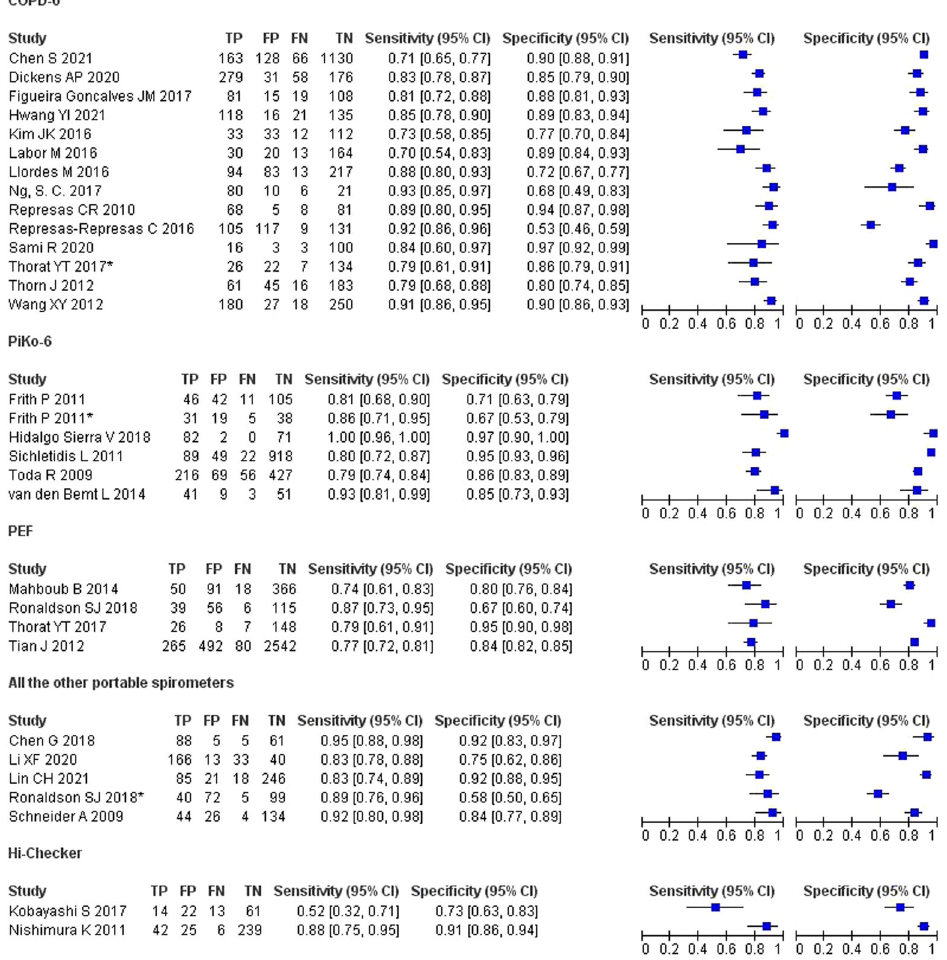
Fig. 5 Forest plot of sensitivity and speci fi city of each screening test. TP true positive, FP false positive, FN false negative, TN true